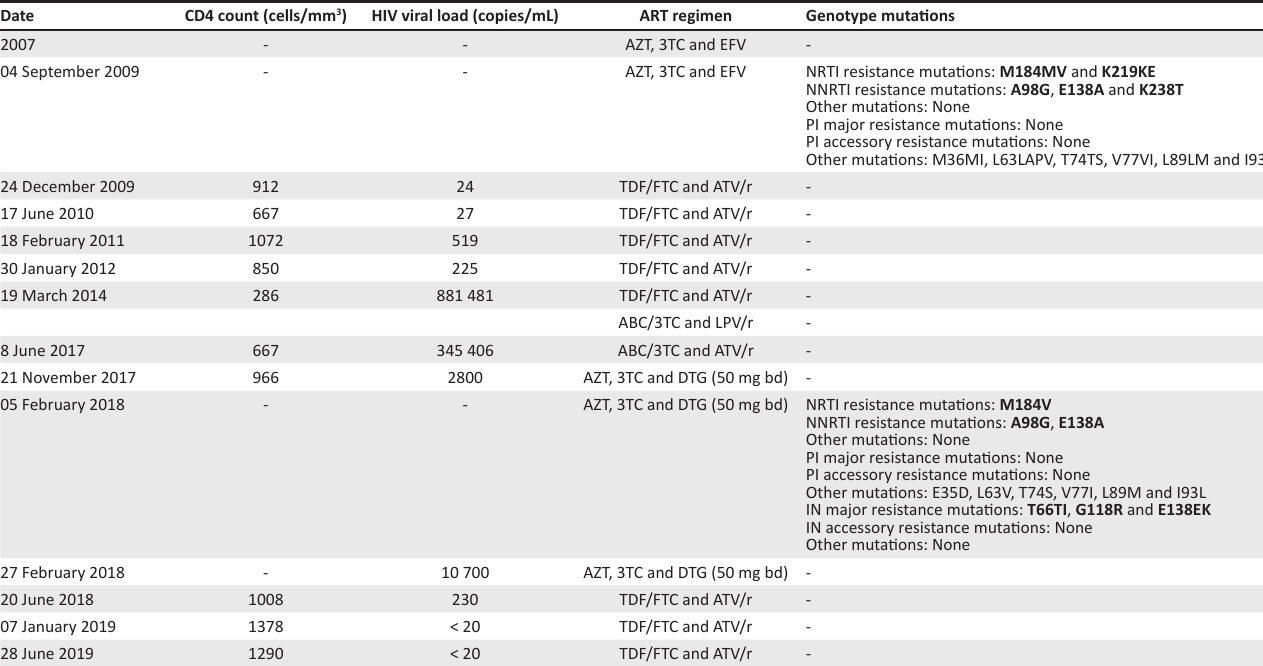
TABLE 1: CD4 count and HIV viral load results available. Date CD4 count (cells/mm 3 ) HIV viral load (copies/mL) ART regimen Genotype